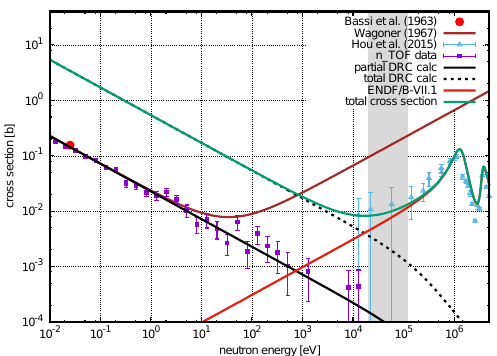
Figure 3. The partial 7 Be(n, γα ) 4 He cross section measured at n_TOF (violet squares), compared with the corresponding one obtained by Direct Radiative Capture (DRC) calculations [17] (solid black curve) and the result of Bassi et al. [6] at 25.3 meV (red circle). The dashed black curve shows the calculated total cross section while the one suggested in Ref. [7] and used in BBN calculations is shown by the brown curve. A combination of the present results with evaluations of Evaluated Nuclear Data File, ENDF/B-VII.1 (red solid curve) provides the total cross section up to a few MeV (green curve). The hatched area shows the neutron energy region of interest for BBN. Reprinted figure with permission from: Barbagallo et al. (n_TOF Collaboration), Phys. Rev. Lett. 117, 152701—2016. Copyright (2016) by the American Physical